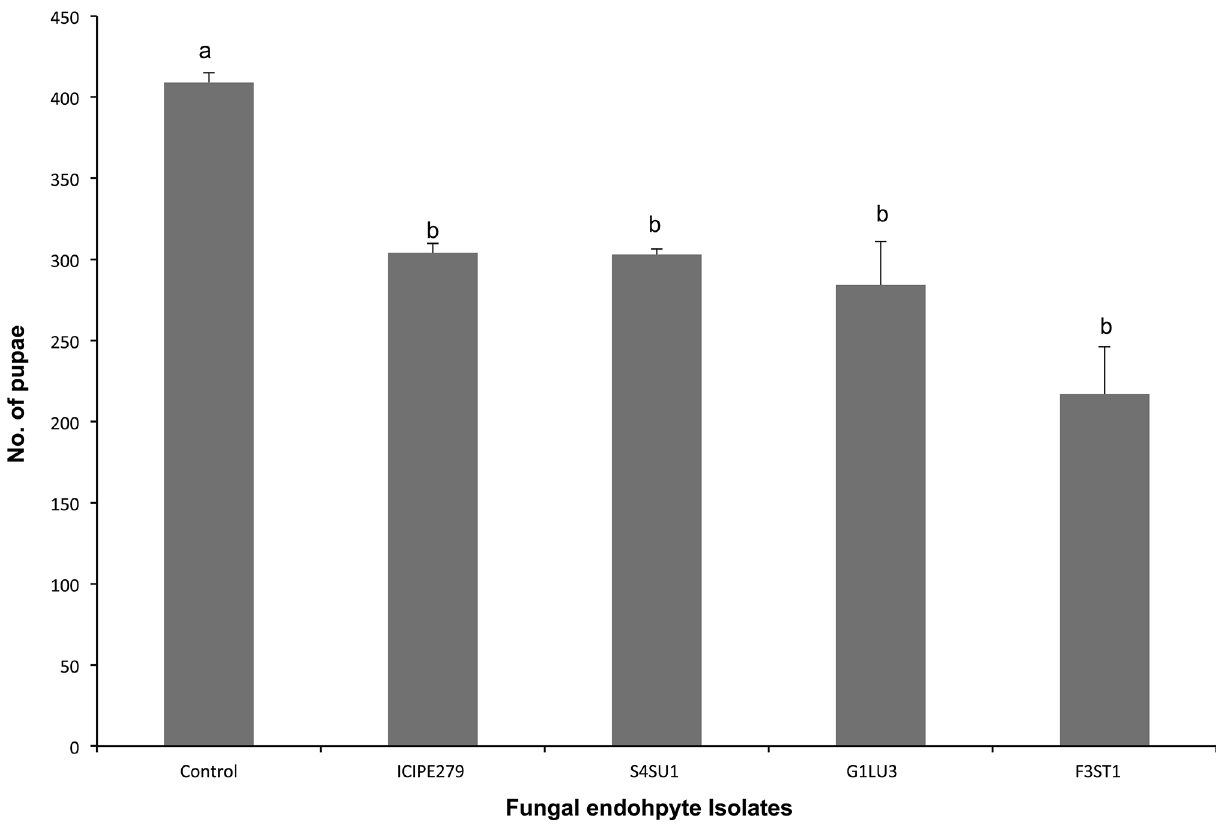
Figure 4. Effect of Viciafaba plants endophytically-colonized by different fungal isolates of Beauveriabassiana (S4SU1, G1LU3 and ICIPE 279) and Hypocrealixii (F3ST1) and infested with 2 nd and 3 rd instar larvae of Liriomyzahuidobrensis on the number of pupae produced after adult parents Phaedrotomascabriventris exposure. Bars denote means 6 one standard error at 95% CI (p=0.05).